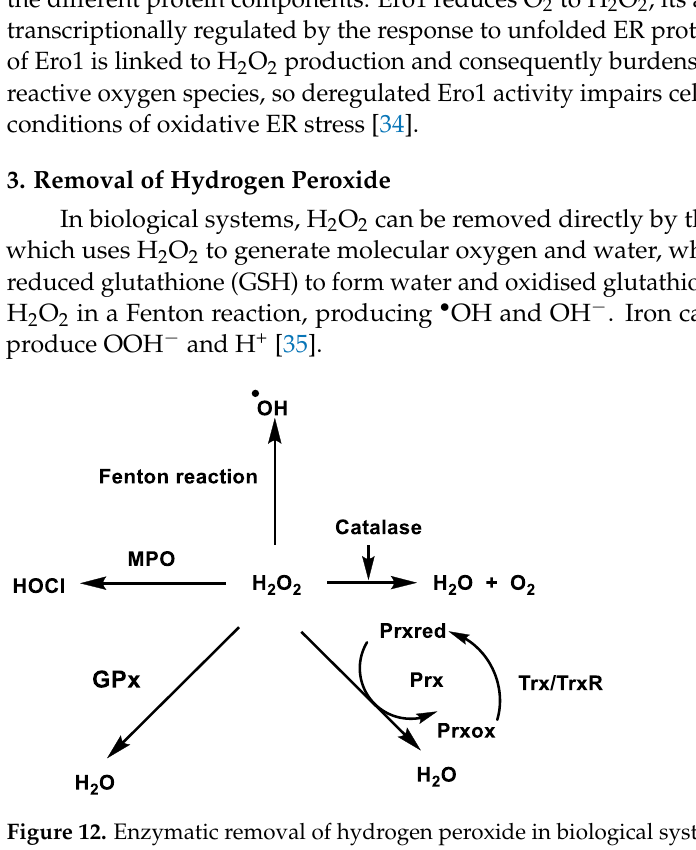
Figure 11. Proposed mechanism of OHCU decarboxylase.